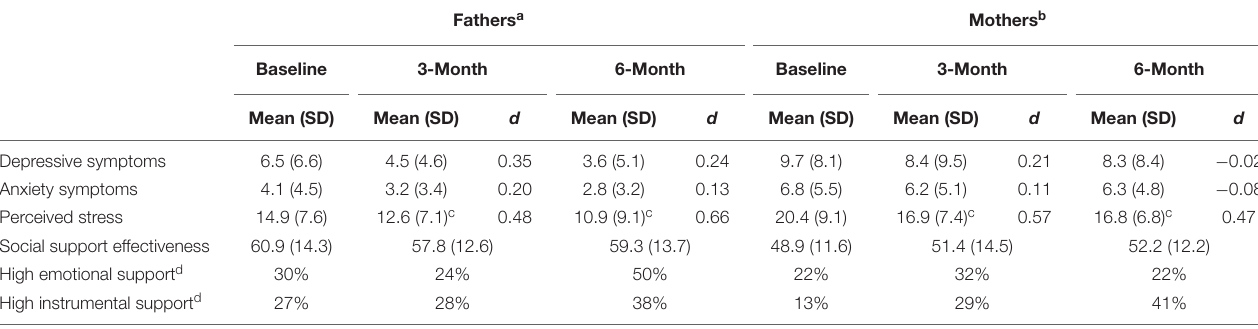
TABLE 4 | Paternal and maternal outcomes from FAB pilot study. Fathers a Mothers